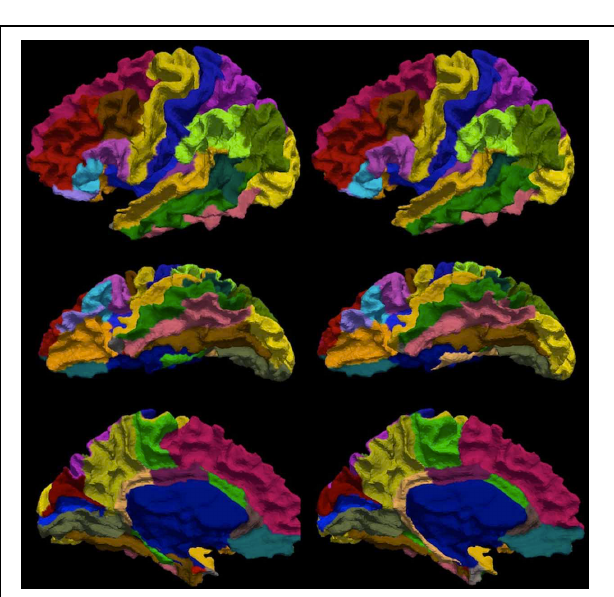
FIGURE 9 | The visual comparison of the FreeSurfer’s (left) and the present (right) parcellation for a single subject. The surface is parcellated into 34 sub-regions defined in Table 5 . The subject is chosen by having the median Dice index of the similarity between the FreeSurfer’s and the present pipeline’s parcellation results. The surface is shown in a lateral (top), ventral (central), and medial (bottom) view.